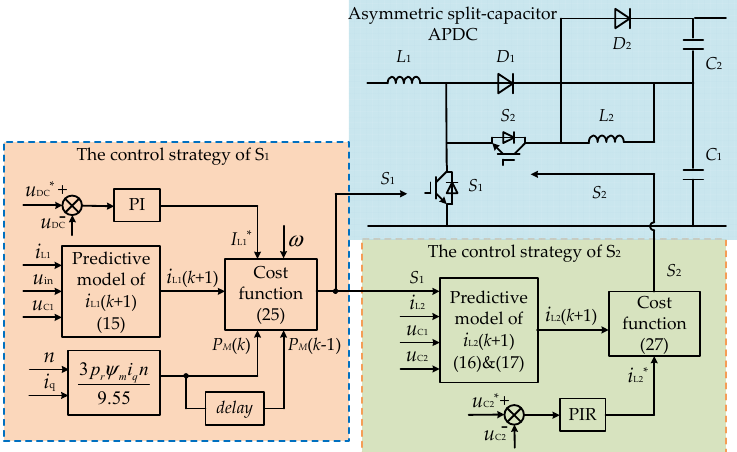
Figure 4. The proposed MPCC control strategy.